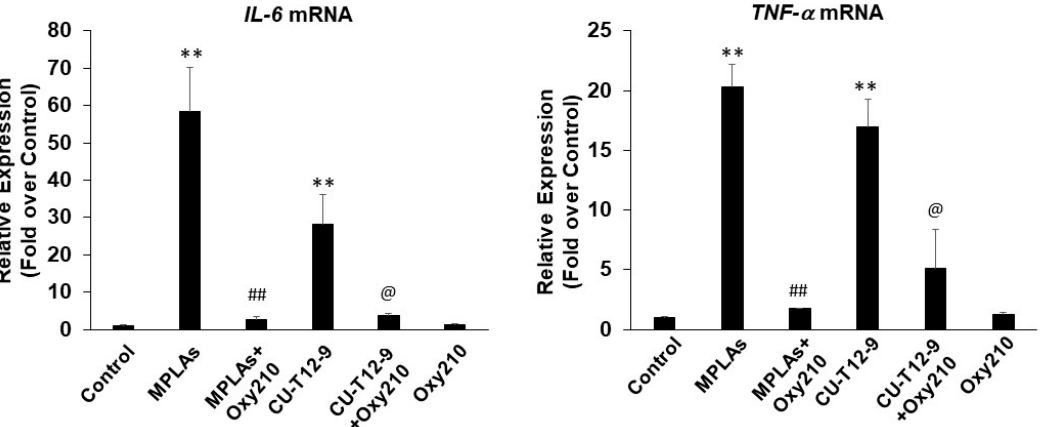
Figure 10. Inhibition of TLR4 and TLR2 agonist-induced inflammatory gene expression by Oxy210 in RAW264.7 macrophages. RAW264.7 cells were pretreated with Oxy210 (5 µ M) in DMEM containing 0.1% FBS for 24 h followed by the addition of TLR4 agonist, monophosphoryl lipid A (MPLAs) (1 μ g/mL), or TLR2 agonist, CU-T12-9 (1 μ g/mL), in the absence or presence of Oxy210 (5 μ M). After 24 h, RNA was extracted and analyzed by Q-RT-PCR for the expression of the genes as indicated and normalized to Oaz1 expression. Data from a representative experiment are reported as the mean of triplicate determinations ± SD (** p < 0.01 vs. control; ## p < 0.01 vs. MPLAs; @ p < 0.05 vs. CU-T12-9).